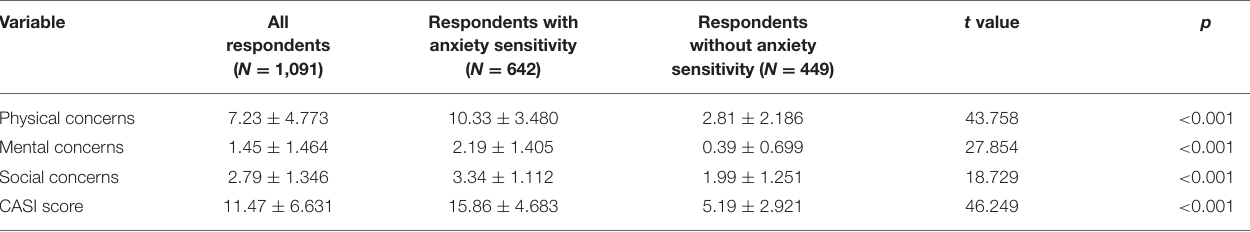
TABLE 2 | CASI scale scores ( ¯ x ± SD ).